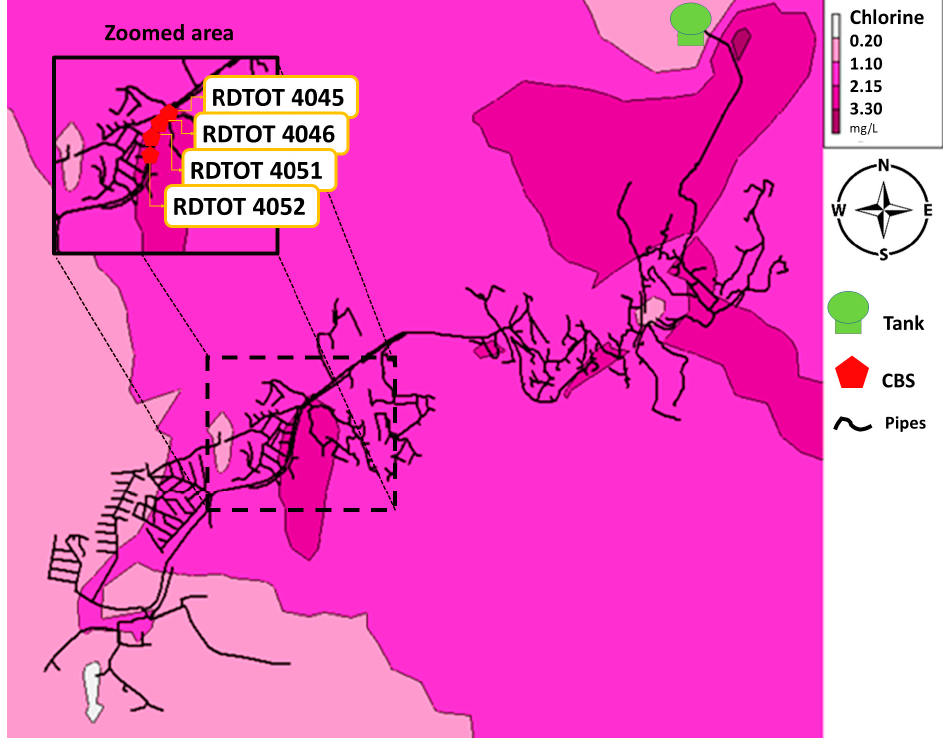
Figure 13. FRC distribution at hour 288 with CBS with fixed pattern dosage of 4 mg/L per hour. The proposal of scheduling with PSO (Figure 14) received a penalty DEL = 5.33 mg/L and a total chlorine injection in the net of 21,912.82 g/day. This increment in the chlorine injection is because of the increment in the range of chlorine injection, and the objective of covering all consumer nodes with minimal FRC, the mean standard deviation is 0.042 mg/L, in the last 24 h for all nodes, and non-consumer nodes with base demand of zero were dismissed. As shown in Figure 14, node RDTOT29 distributes chlorine 24 h per day while auxiliary CBS focuses on distributing chlorine during the night period. This happens because during the night consumers are sleeping, and the water remains in the pipe system, so the water is mainly taken from the pipelines rather than the tank.